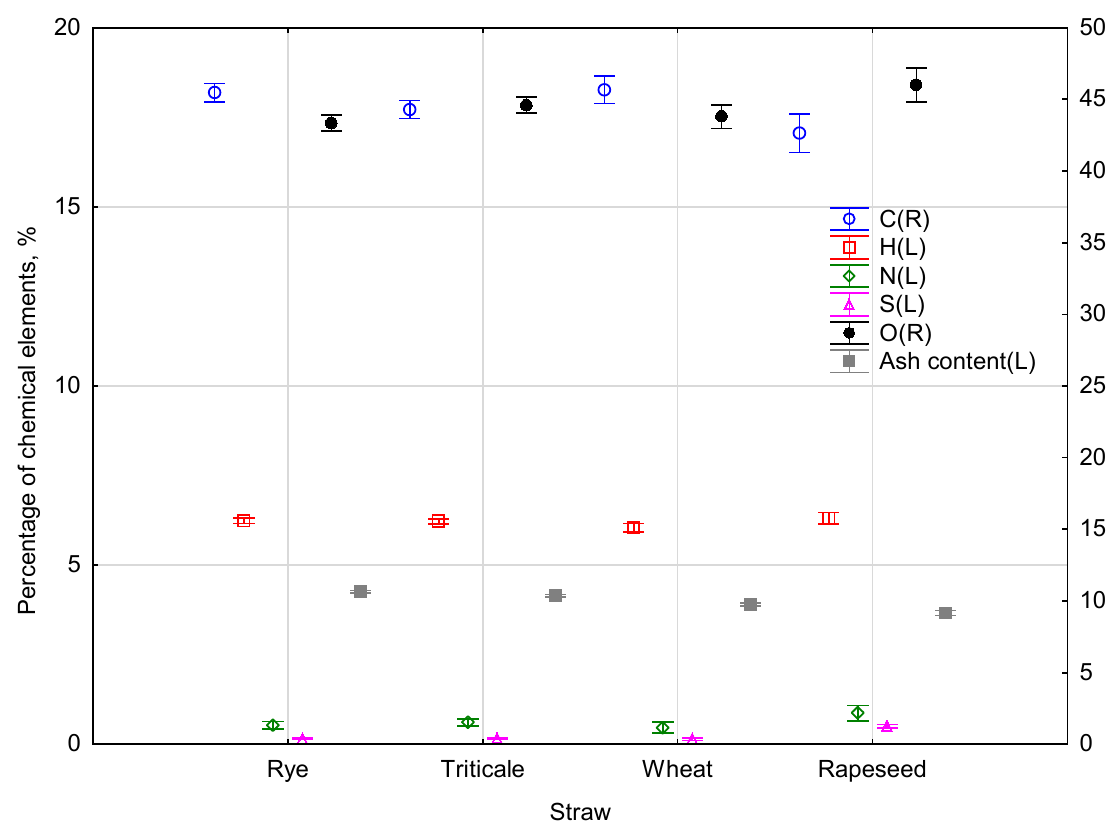
Figure 2. Sum of the chemical composition of straw from various harvesting sources.